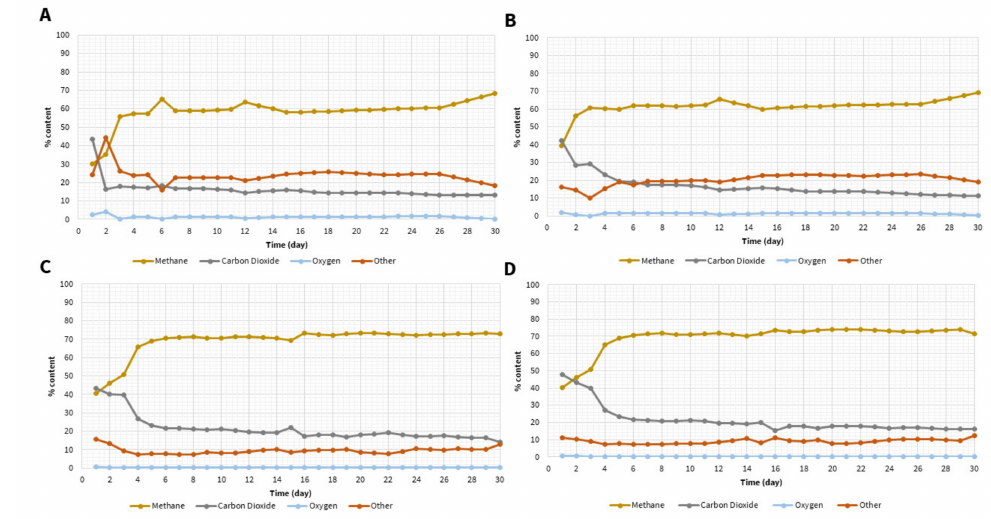
Figure 4. Percentage composition of produced biogas in relation to methane, carbon dioxide, oxygen, and other gases for: ( A ) Test I; ( B ) Test II; ( C ) Test III; ( D ) Test